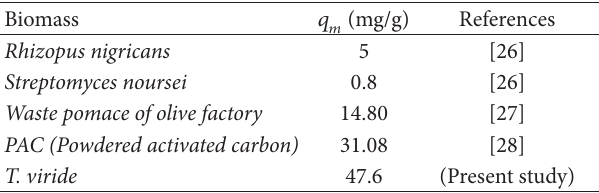
T 3: A comparison of biosorption capacity (mg/g) of different biomasses for Ni(II)